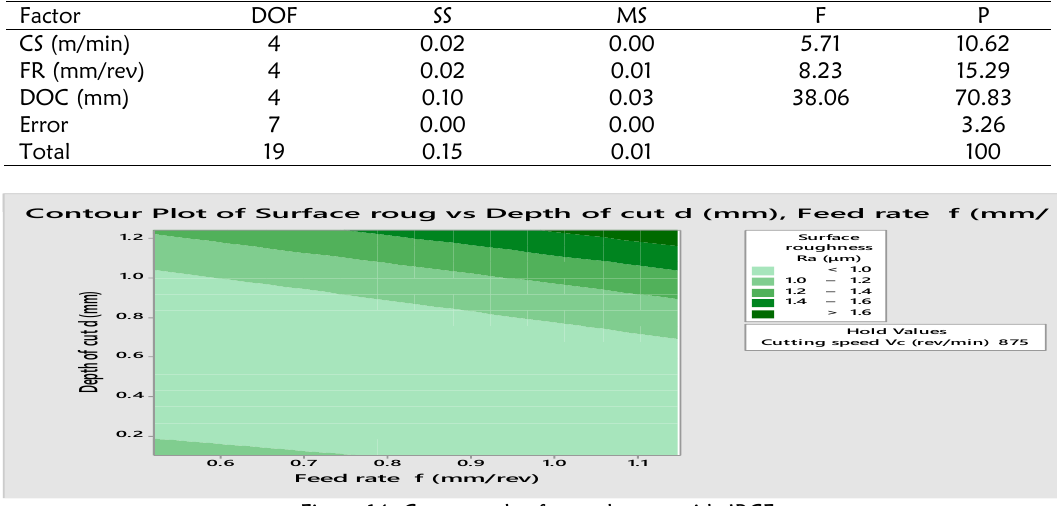
Table 14: ANOVA for tool wear, Tw (mm)